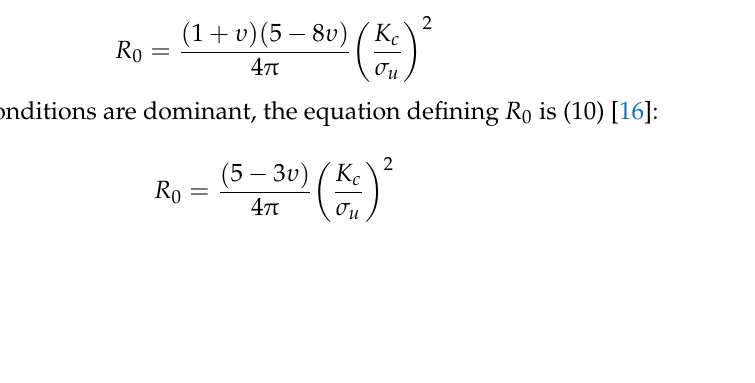
Figure 2. Control volume (area) for sharp V-notch ( a ); crack ( b ) and blunt V-notch ( c ) under mode I loading [16].